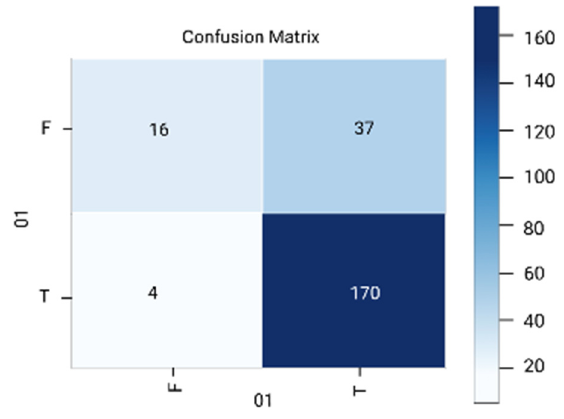
Figure 7. Random forest.